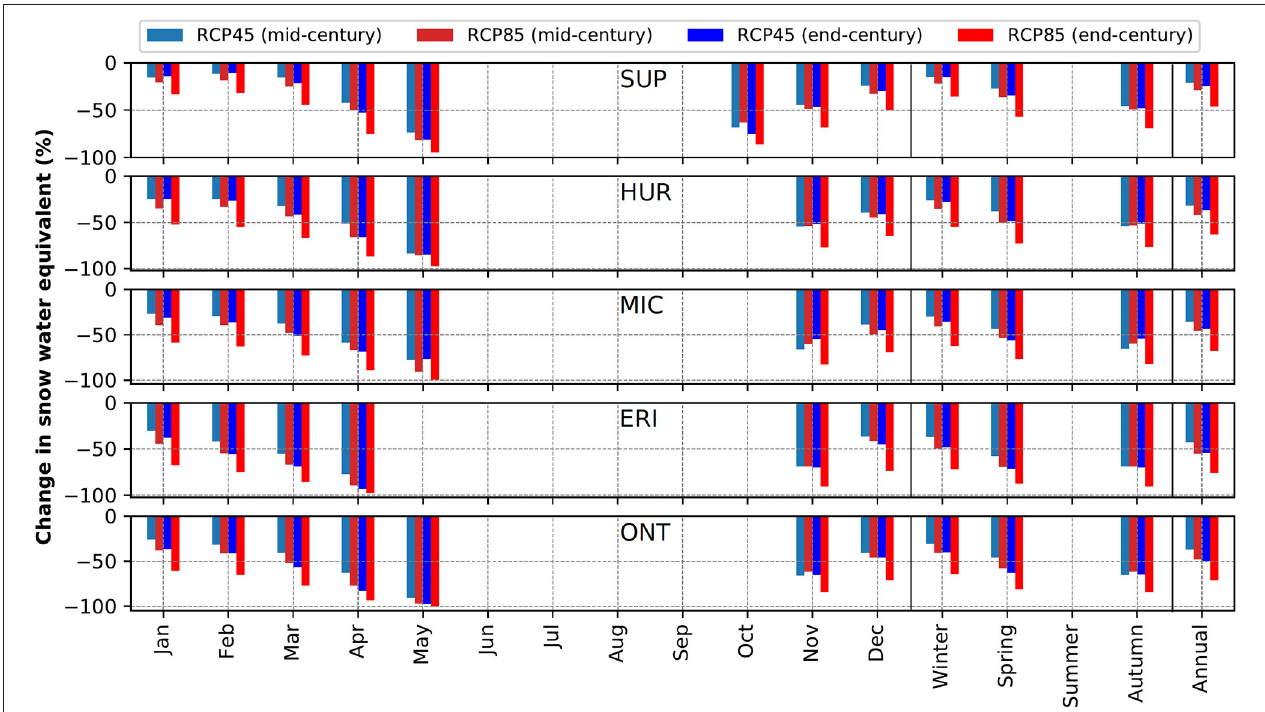
FIGURE 10 | Percentage change in monthly, seasonal, and annual snow water equivalent (SWE) with respect to the baseline value for RCP 4.5 and RCP 8.5 scenarios in both mid- and end-century